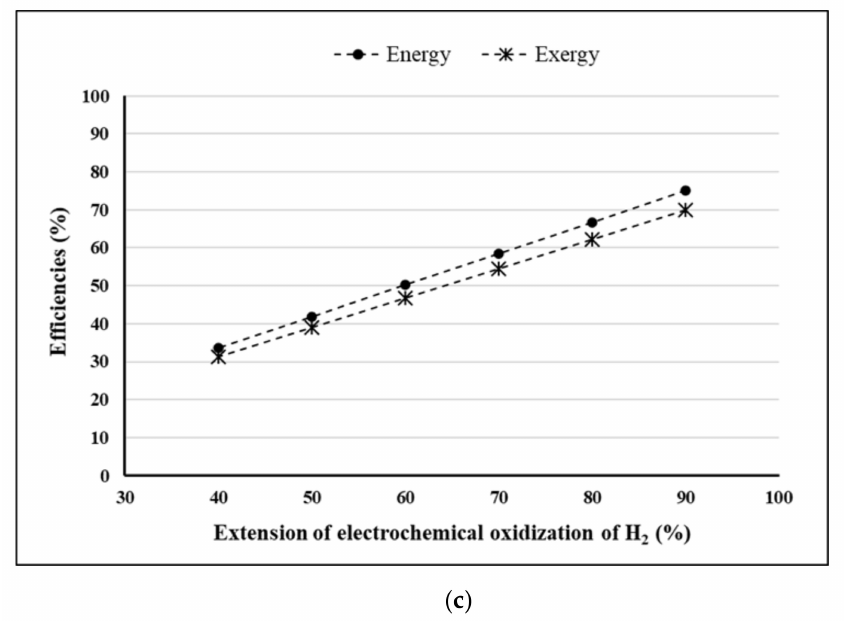
Figure 3. System’s efficiency as a function of extension of reforming reaction ( a ), extension of WGS reaction ( b ) and extension of electrochemical oxidation ( c